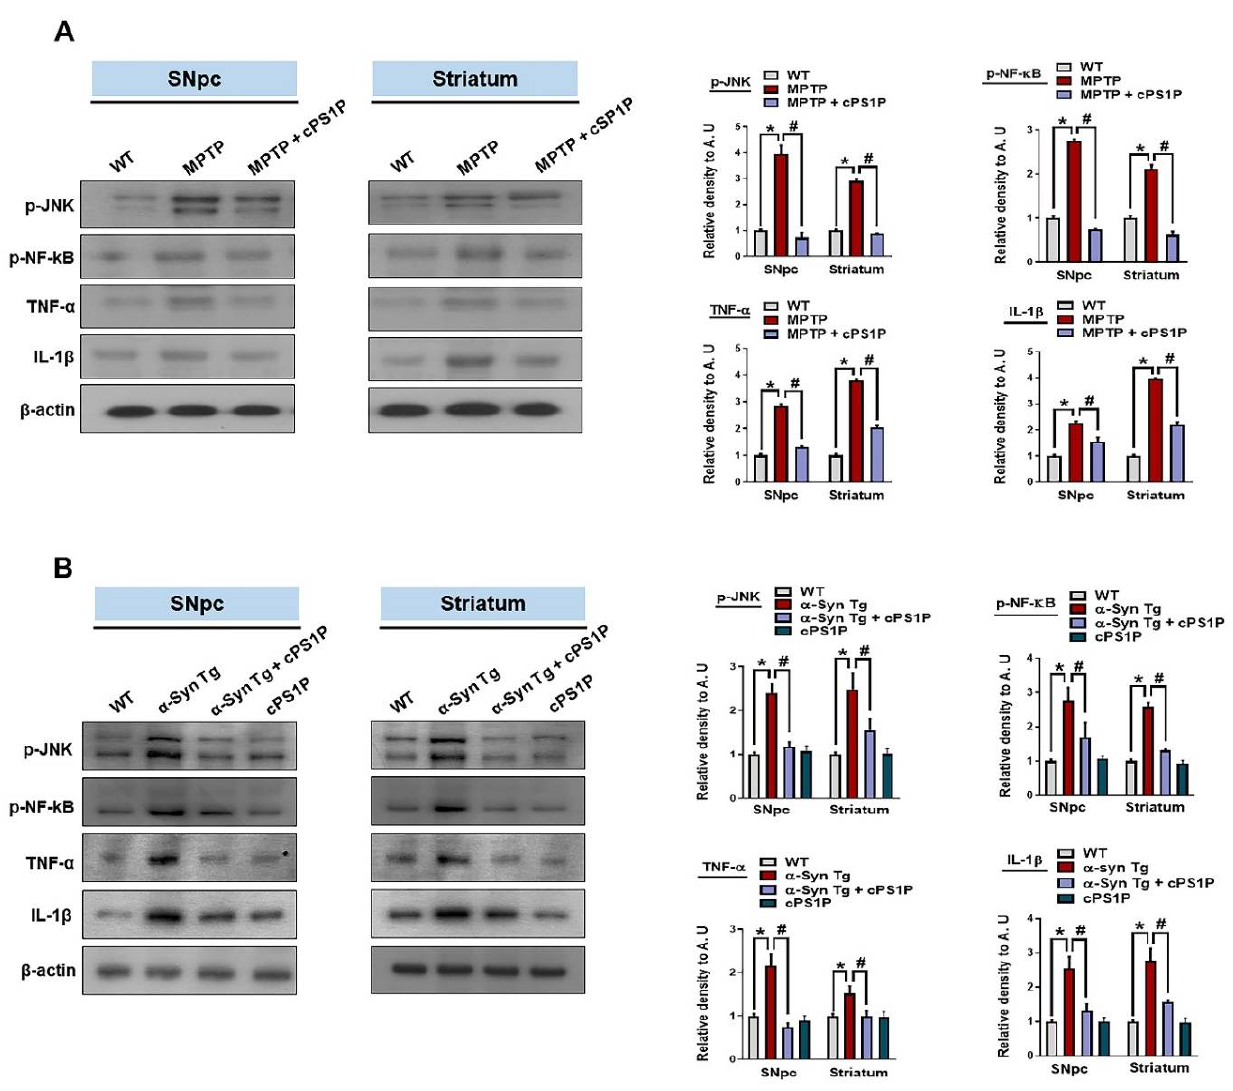
Figure 7. cPS1P prevents PD-induced activation of p-JNK and neuroinflammatory factors in